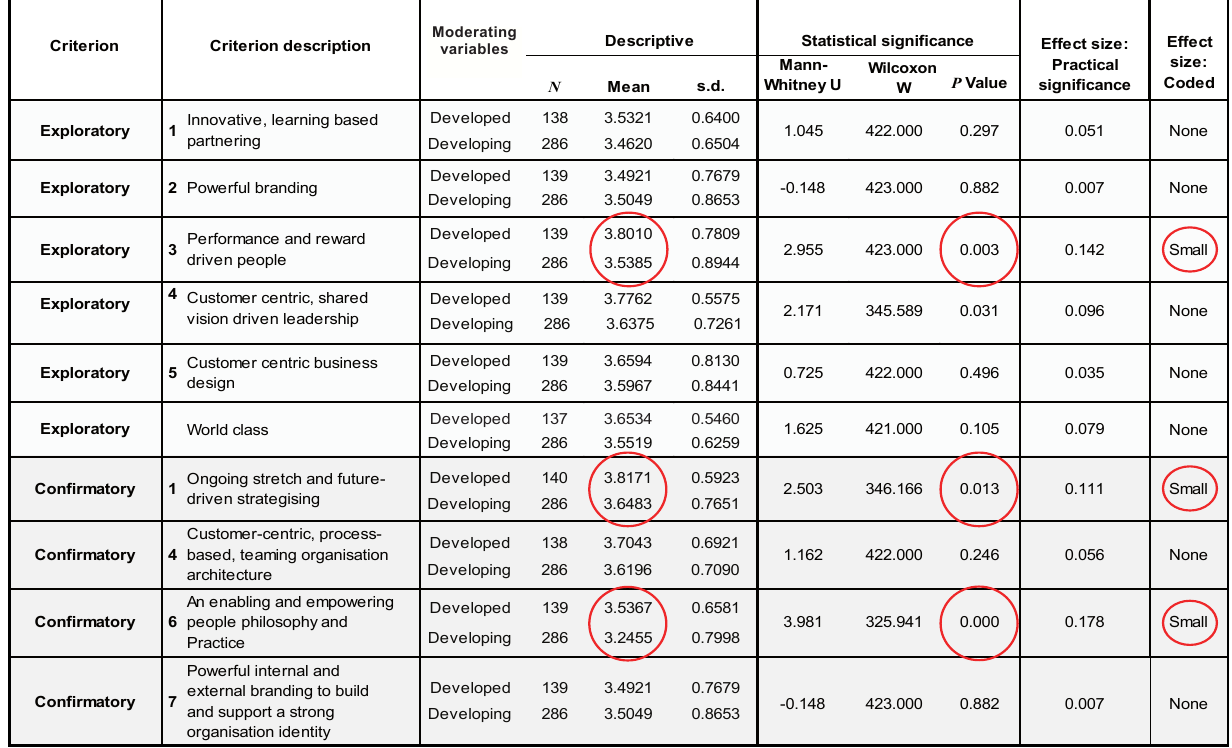
TABLE 2 Individual respondents as unit of analysis: developed versus developing